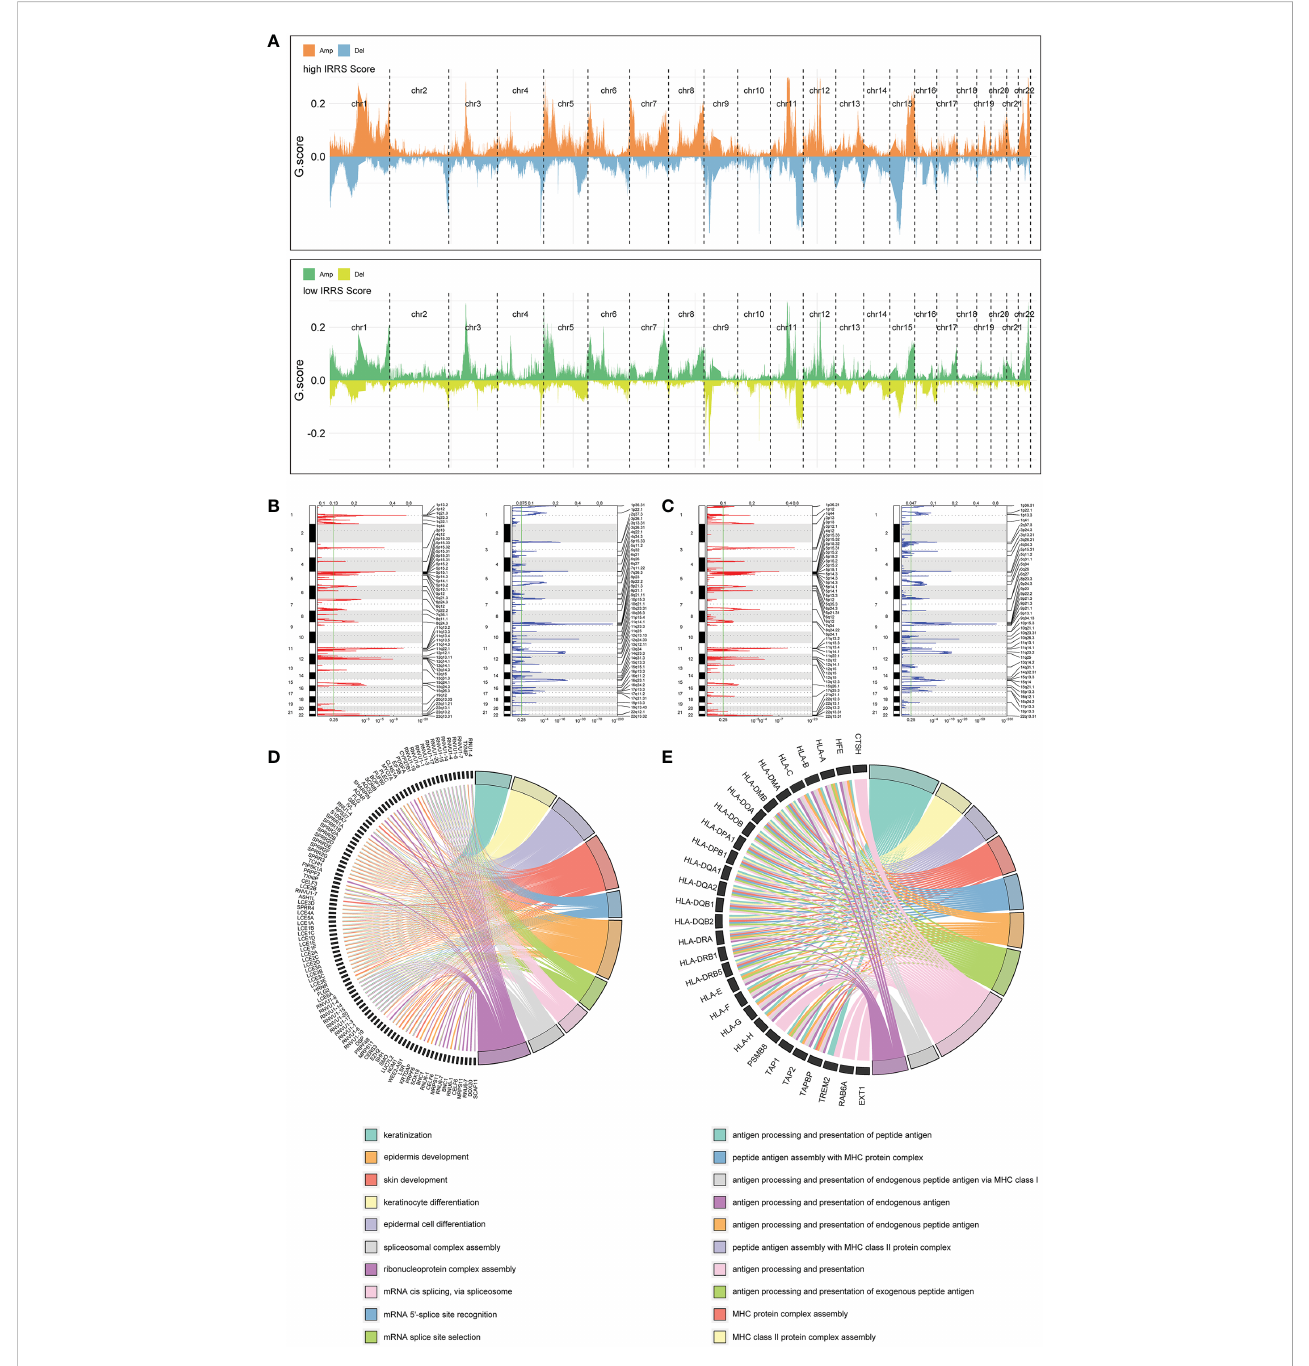
FIGURE 6 Copy number alterations in the high- and low-score groups. (A) Copy number pro fi les of the high IRRS score (above) and low IRRS score (below) groups. (B) Detailed cytobands with focal ampli fi cation (red) and deletion (blue) peaks identi fi ed in the high IRRS group. (C) Detailed cytobands with focal ampli fi cation (red) and deletion (blue) peaks identi fi ed in the low IRRS group. (D) Circular plot of the top 10 biological processes and corresponding enriched genes in the high IRRS. (E) Circular plot of the top 10 biological processes and corresponding enriched genes in the low